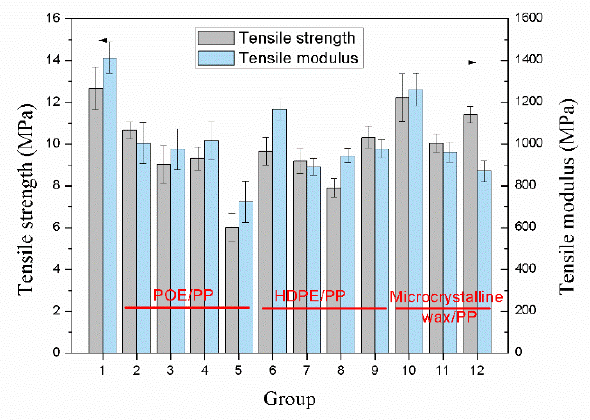
Figure 8. Flexural strength and modulus of the samples with different polymer blends.